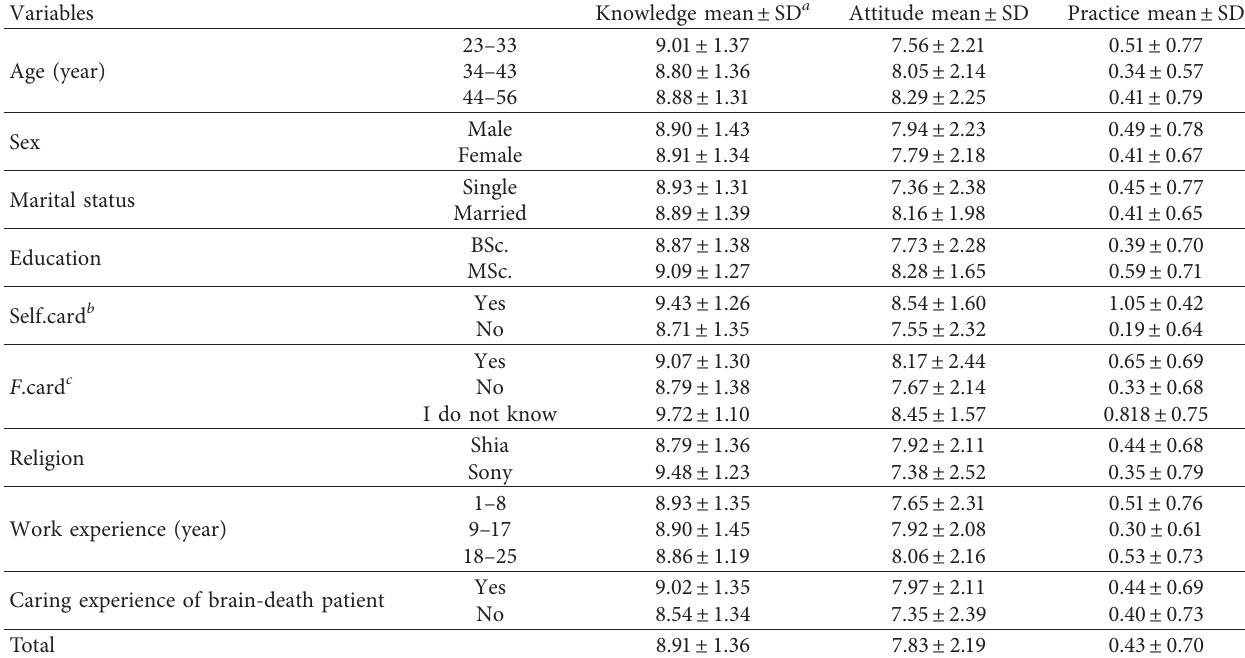
Table 2: Nurses’ mean knowledge, attitude, and practice in terms of demographic variables.